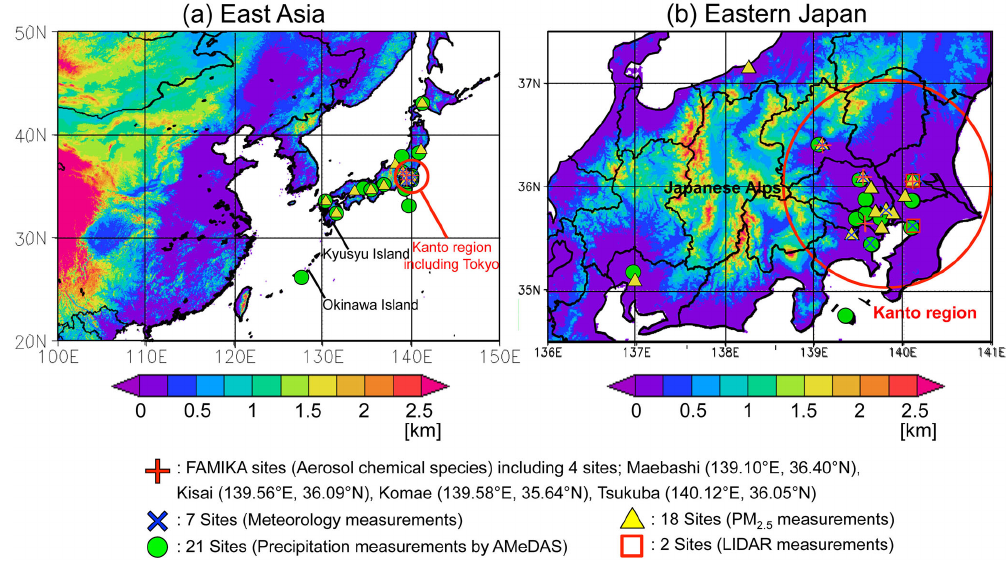
Figure 1. Topographical maps of (a) East Asia and (b) eastern Japan, including the observation sites for the model validation. The topography is based on GTOPO30 (the horizontal resolution is 30arcs, that is, approximately 1km) courtesy of the US Geological